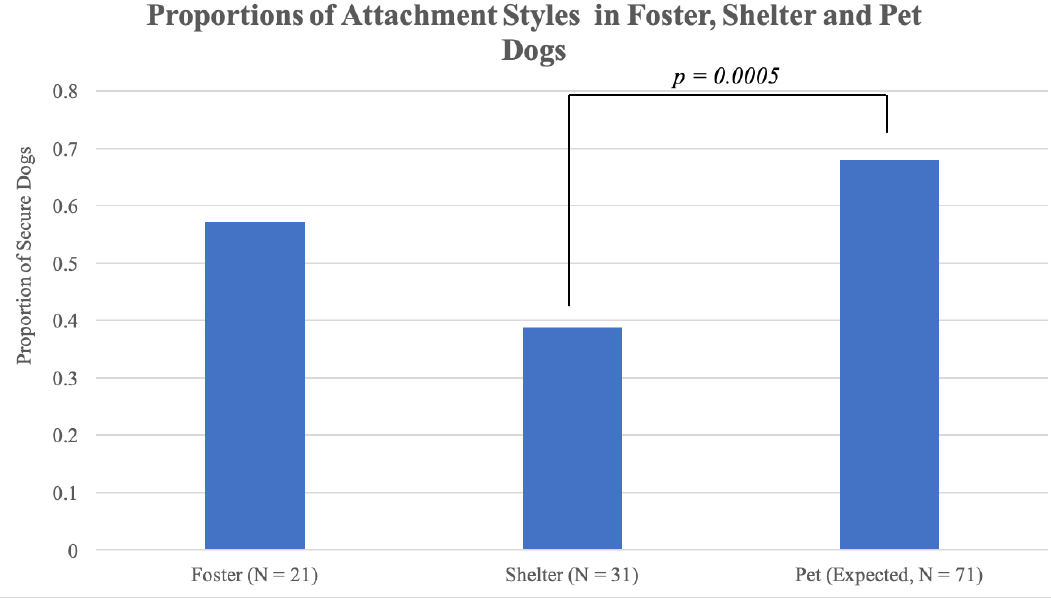
Figure 3. Proportions of observed foster and shelter dogs categorized as secure, compared to expected proportions of pet dogs with secure attachments based on published literature [5 – 7]. proportions of pet dogs with secure attachments based on published literature